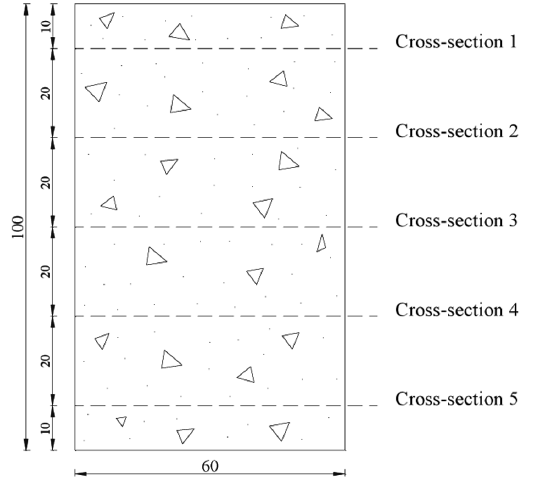
Fig. 9. Division of scanning cross-sections (unit: mm)